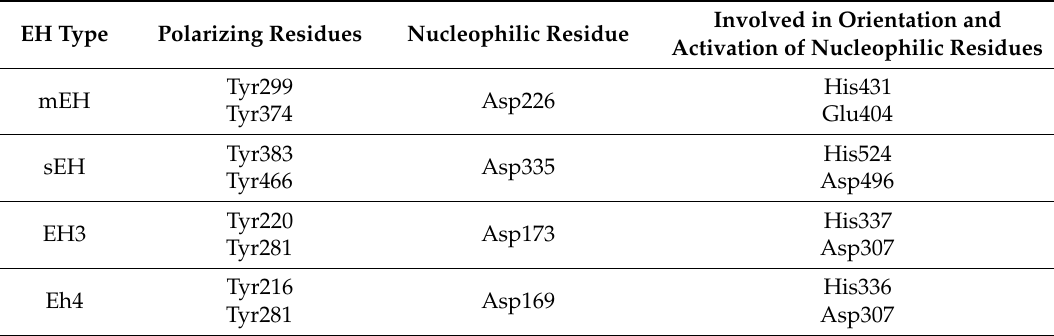
Table 1. Di ff erent residues in the catalytic triad of mEH, sEH, EH3, and EH4 and their function. EH Type Polarizing Residues Nucleophilic Residue